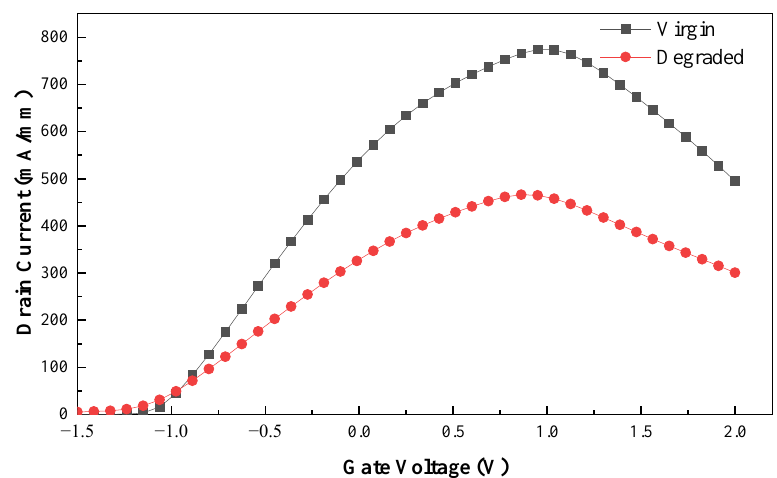
Figure 8. The distributions of temperature: ( a ) 1.0 ns; ( b ) 1.4 ns.